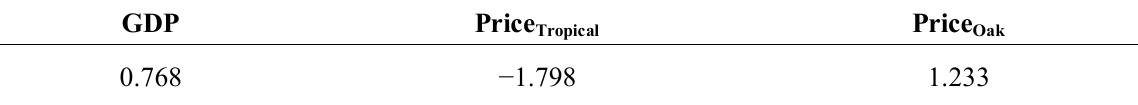
Table 1. Tropical lumber import demand